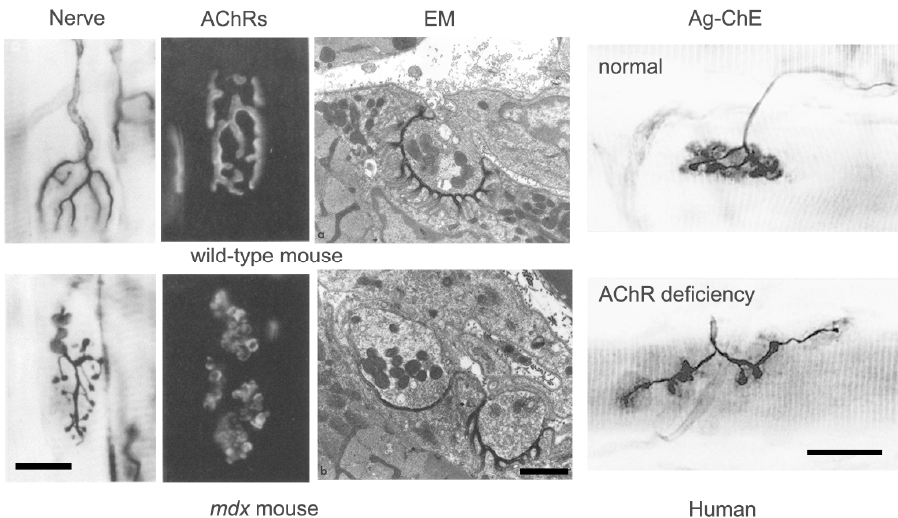
Figure 7. Pathological features of NMJs. The images of mouse NMJs show, from left to right, the nerve, the distribution of AChRs and the ultrastructure. The upper images show NMJs from wild-type mice while the lower images show NMJs from dystrophin-deficient mdx mice, in which most muscle fibers degenerate, and then regenerate. Note the dramatic change in the conformation of the nerve terminal and the associated AChRs in the mdx mice, reflecting a new pattern of innervation established when the nerve reinnervates regenerated muscle fibers. In the EM images, note the presence of region of normal folding, presumed to be original contacts, adjacent to a region devoid of folding, presumed to be a new contact. Scale bars, light-micrographs, 20 µ m, EM images, 1 µ m. (From Lyons and Slater, 1991, with permission) [39]. The images of human NMJs are from a normal patient ( top ) and a patient with inherited AChR deficiency ( bottom ). Scale bar, 20 µ m. (From Slater et al., 1997, with permission) [37].